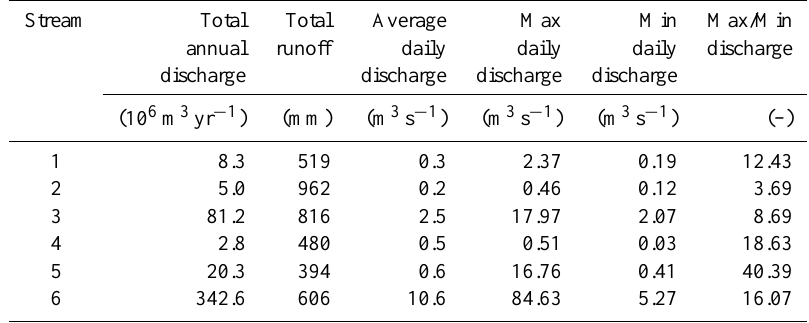
Table 2. Stream flow characteristics for the six catchments considered in this study. Stream Total Total Average Max Min Max/Min annual runoff daily daily daily discharge discharge discharge discharge